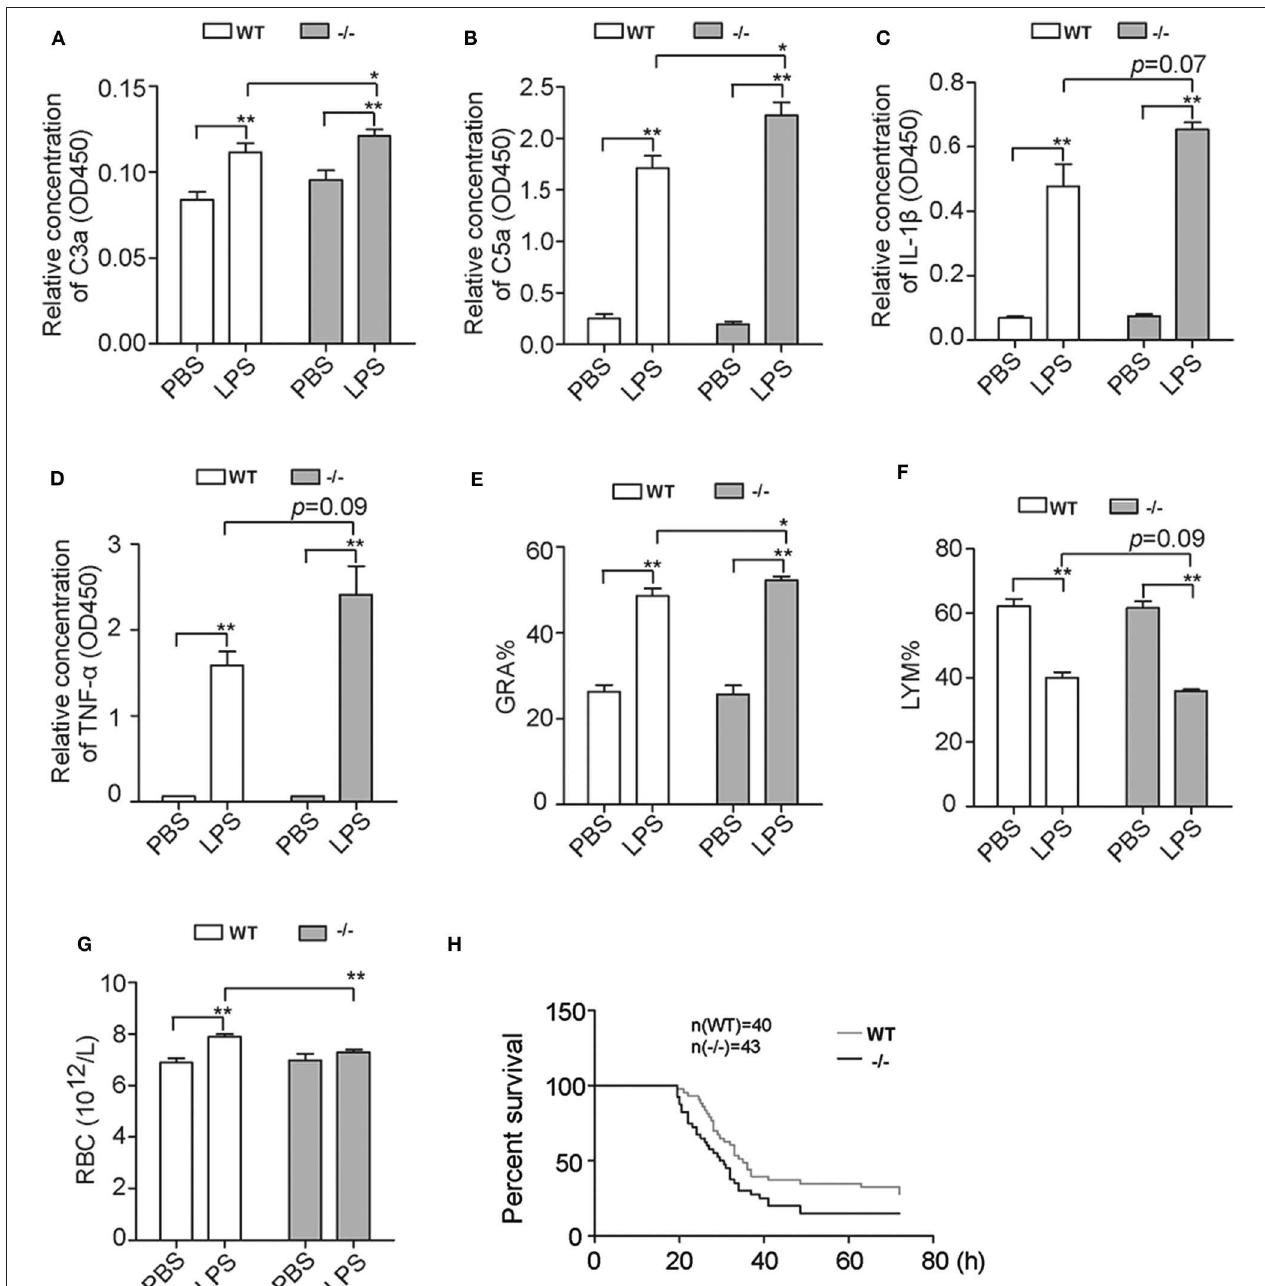
FIGURE 6 | Detection of complement-activated products and blood cells after in vivo LPS challenge. (A,B) C3a and C5a concentration measurements with ELISA kit at 3h after in vivo LPS challenge. Four mice in each group were included. (C,D) IL-1 β and TNF- α concentration measurements with ELISA kit at 3h after in vivo LPS challenge. Three mice in each group were included. (E–G) Percentages of granulocytes and lymphocytes at 6h after LPS challenge and red cells at 12h after LPS challenge measured by animal blood analyzer. GRA, granulocytes. LYM, lymphocytes. RBC, red blood cells. Four mice in each group were included. (H) The survival data of two groups with i.p. injection of 10 mg/kg LPS. The data were analyzed by Gehan–Breslow–Wilcoxon test. The number of wild-type mice and Cfhr1 − / − mice was 40 and 43, respectively. * p < 0.05, ** p < 0.01.